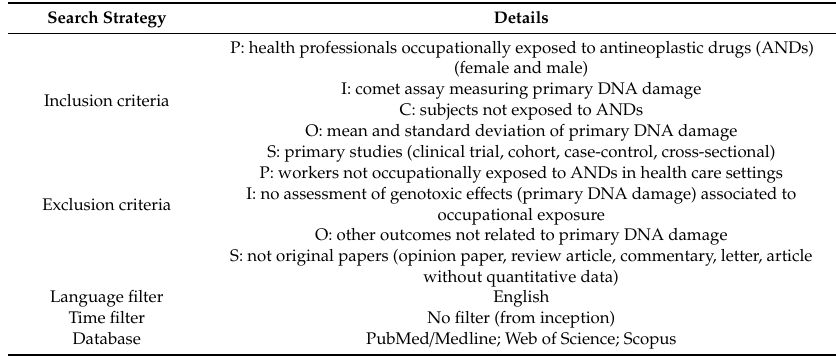
Table 1. Detailed inclusion / exclusion criteria, according to a population, intervention, comparison, outcomes, and study design (PICOS) statement extended with a language and time